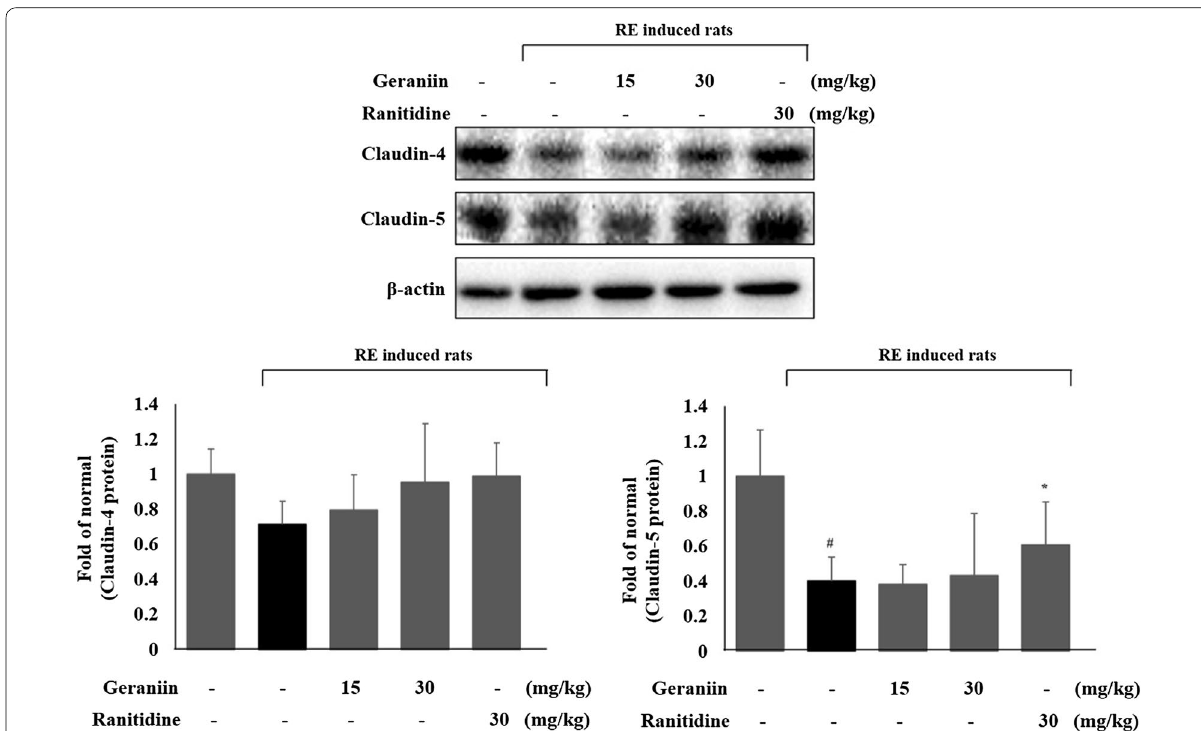
Fig. 6 Effects of geraniin on TJP (claudin-4 and claudin-5) in esophageal damage by RE rats. Rats were pre-treated with 15 and 30 mg/kg body weight geraniin, and 30 mg/kg ranitidine excluding normal and RE control for 90 min before surgery. Then, 5 h later, the esophageal mucosa was cut, and collected from each rat. Data are mean standard deviation (SD). Significance: # p < 0.05 and * p < 0.05 compared with normal control and ± RE control groups,